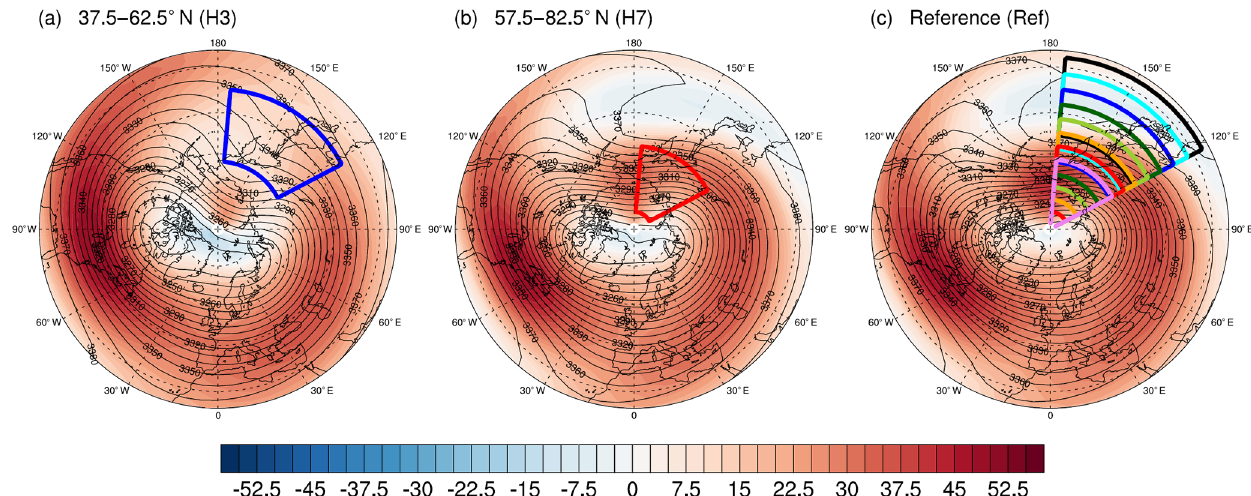
Figure 5. Zonal wind (ms − 1 ) in color and geopotential height (gpdam) as contour lines north of 25 ◦ N at 35km for the H3 (a) , H7 (b) and the Ref (c) simulations, representing the last 30d of analysis. The boxes illustrate the position of each GW hotspot: H1 (in black) to H8 (in violet). The blue (a, c) (red, b, c ) box refers to the H3 (H7)